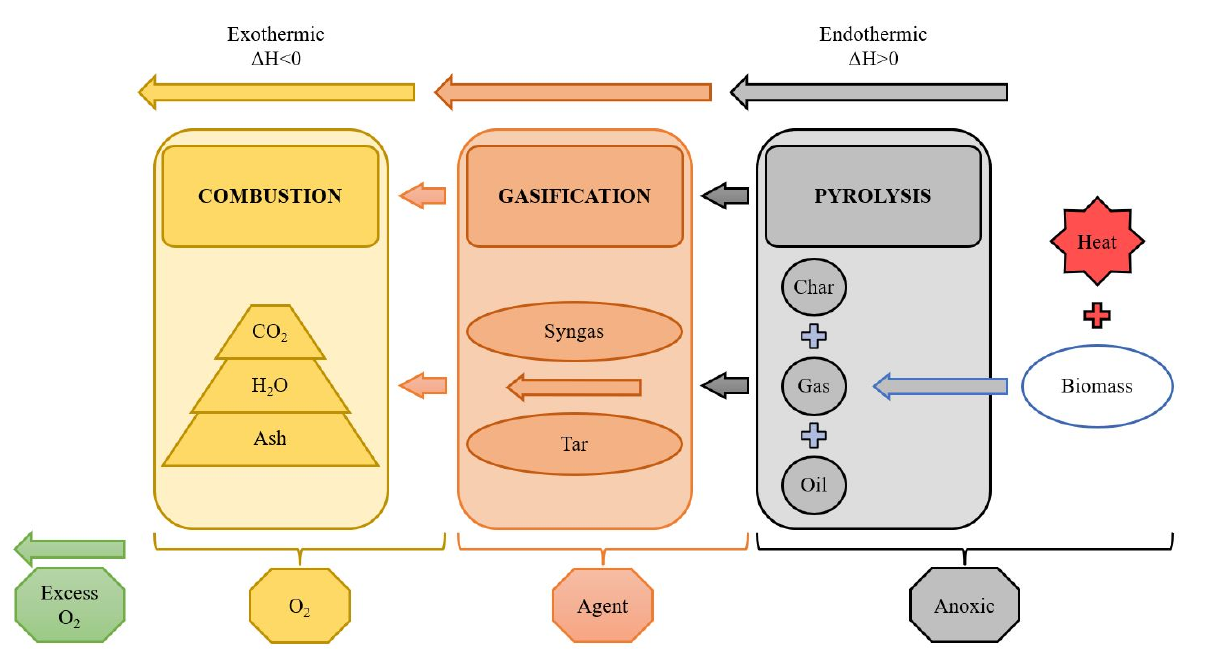
Figure 2. Three common thermal treatment routes [58].